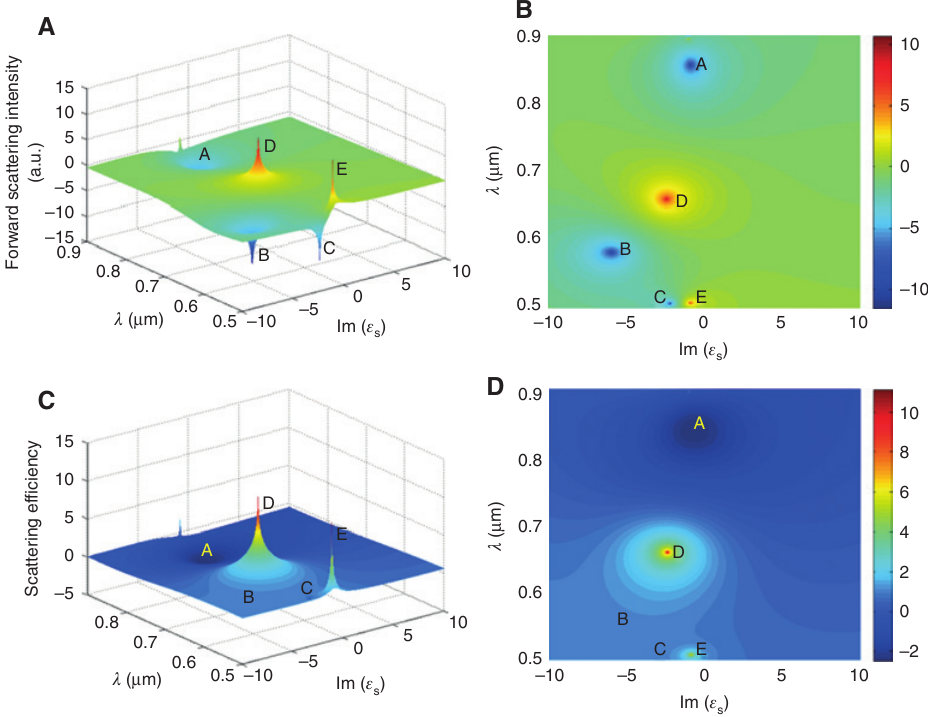
Figure 2: (A) Forward scattering intensity (logarithmic scale) in three-dimensional scale for core-shell spherical particles with an inner radius of 0.07 μ m and an outer radius of 0.1 μ m as a function of the incident wavelength λ and the imaginary part of permittivity for dielectric shell Im( ε ). (B) Corresponding forward scattering spectra in two-dimensional pseudocolor view. (C) Total scattering intensity s (logarithmic scale) in three-dimensional scale for the above core-shell spherical nanoparticles as a function of the incident wavelength λ and the imaginary part of permittivity for dielectric shell Im( ε ). (D) Corresponding total scattering spectral in two-dimensional pseudoc- s olor